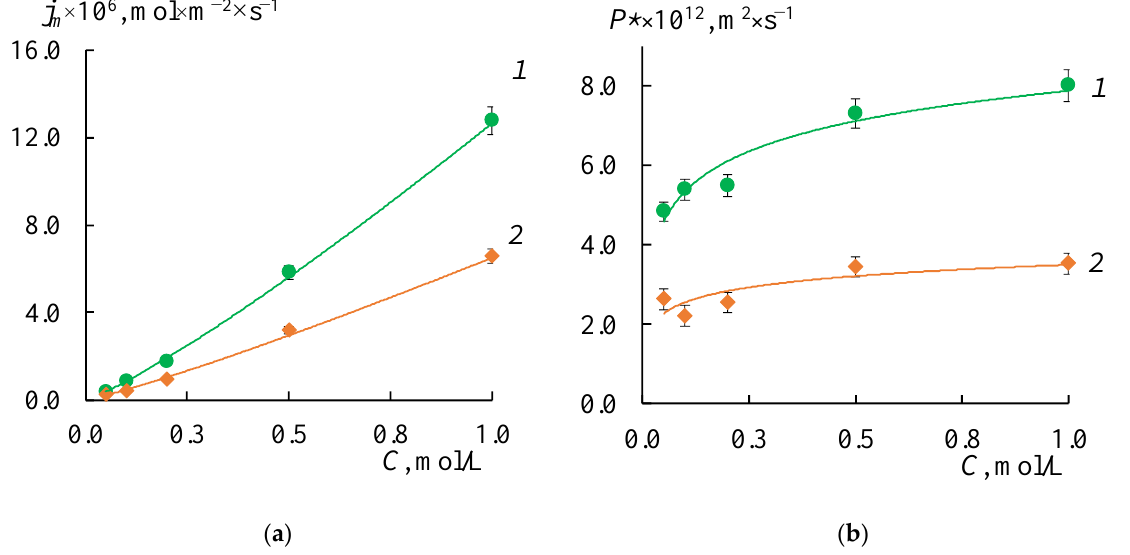
Figure 7. The concentration dependencies of the diffusion flux densities ( a ) and the differential diffusion permeability coefficient ( b ) of the MK-40 (1) and MA-41 (2) membranes in the NaCl solutions.